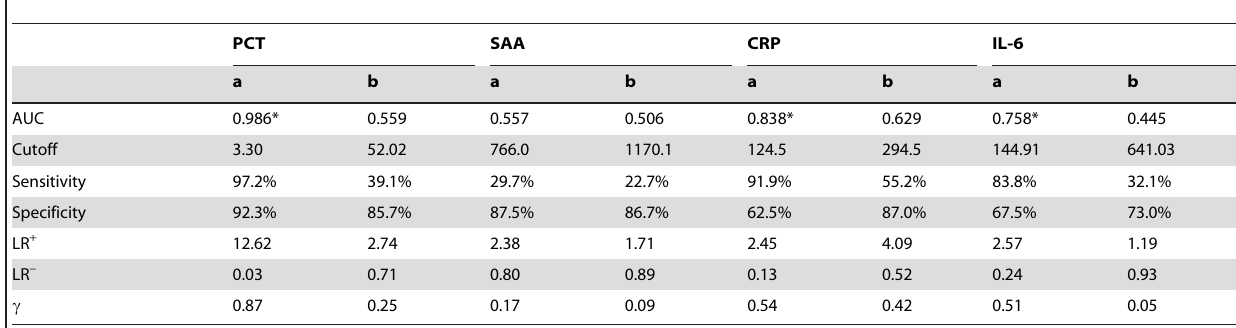
Table 3. Predictive performance comparison of PCT, SAA, CRP, and